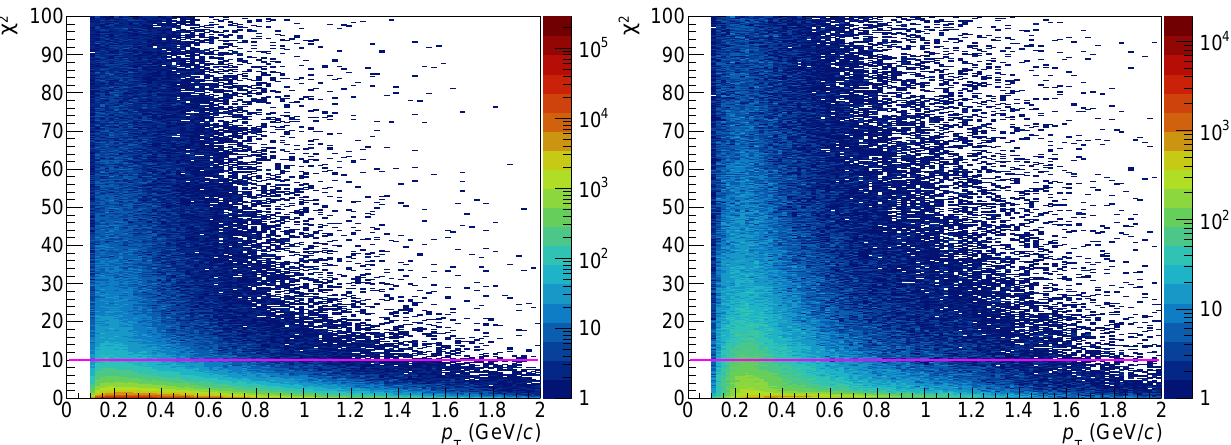
Figure 3. Distributions of signal ( left ) and background ( right ) pairs as a function of the vertex χ 2 and transverse momentum of the reconstructed pair. Selection limits are shown with magenta lines.